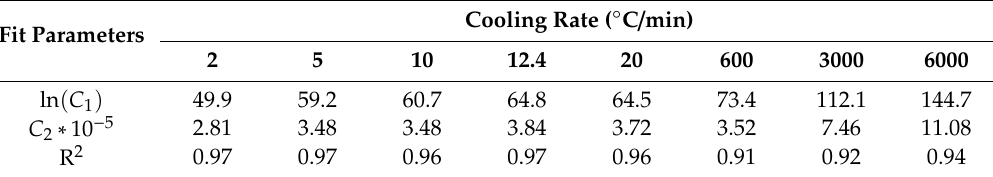
Table 2. Fit parameters for the Hammami model to predict the relative crystallinity at different cooling rates. The R² values for the fits are high for the low cooling rates. However, for high cooling rates the model loses accuracy.